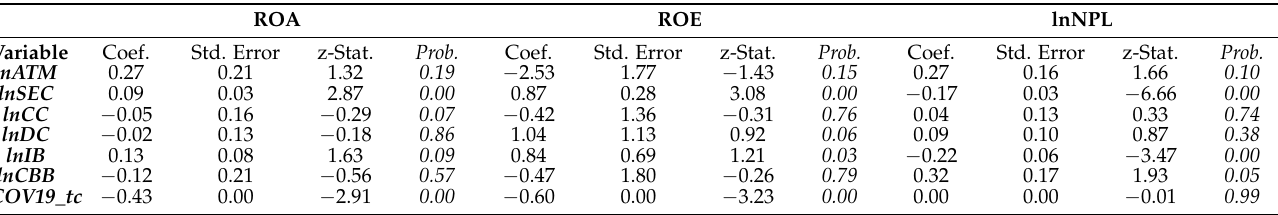
Table 3. Robust least squares M estimation